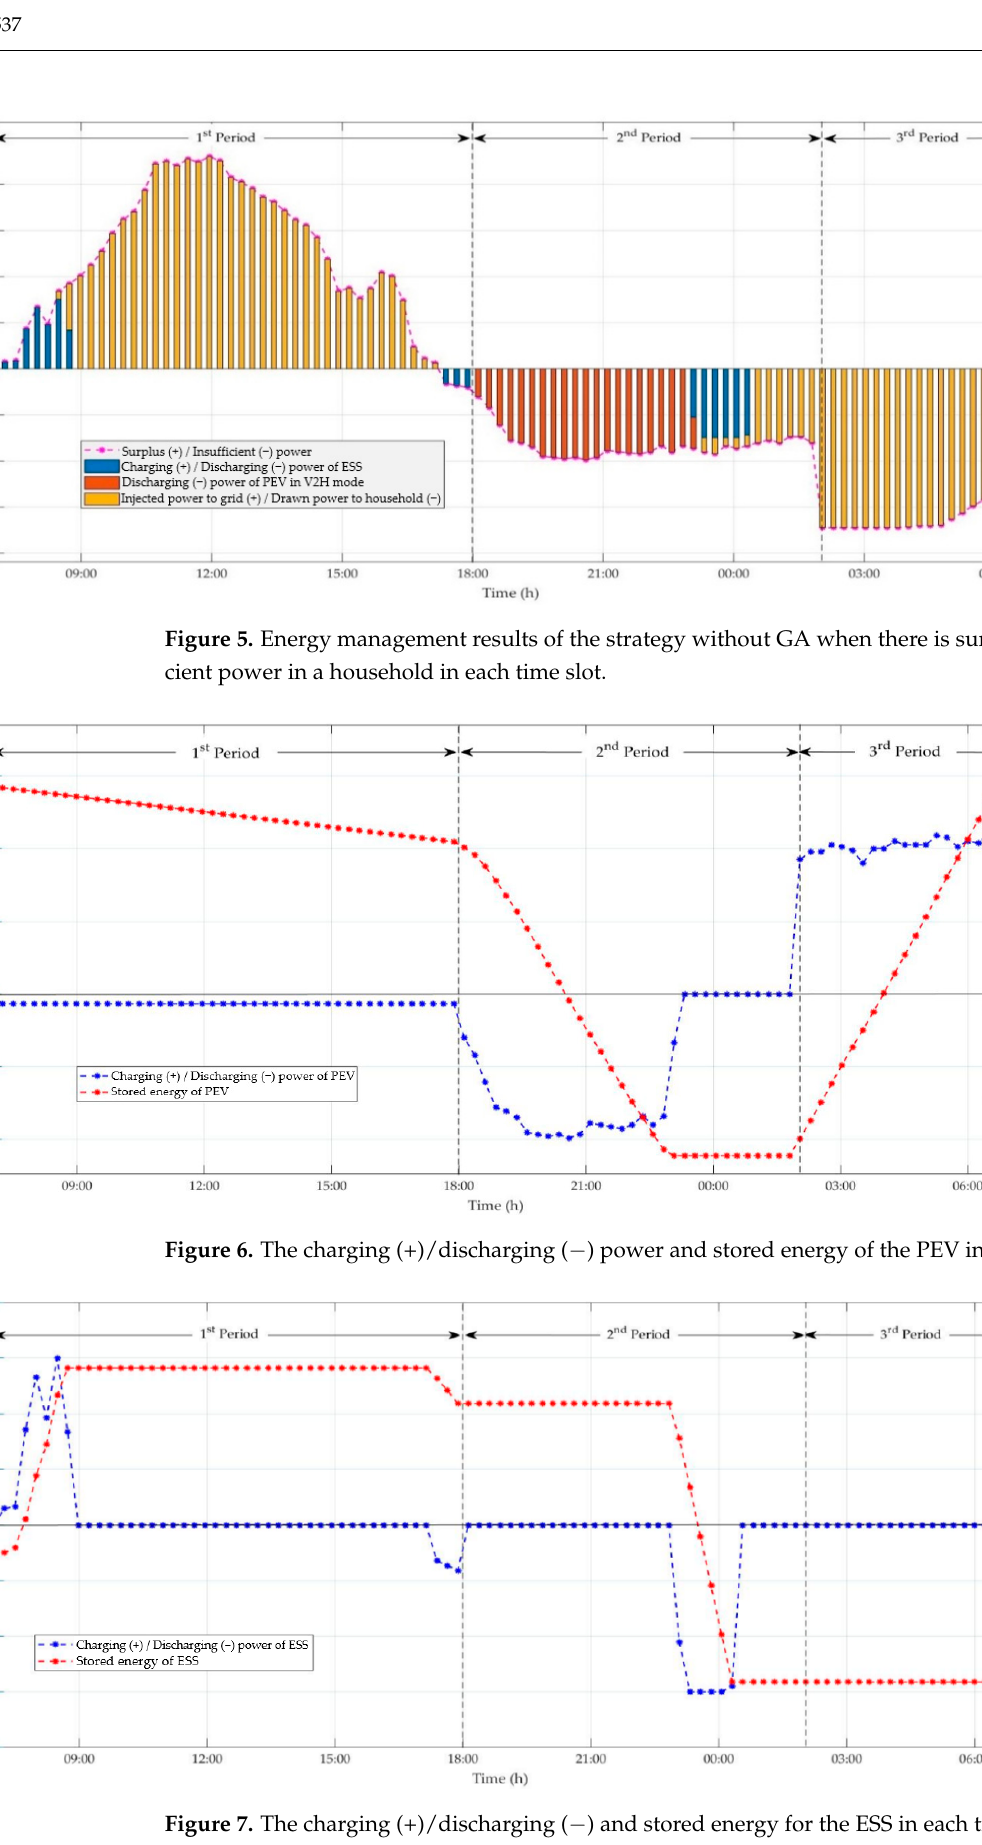
Figure 7. The charging (+)/discharging ( − ) and stored energy for the ESS in each time slot.